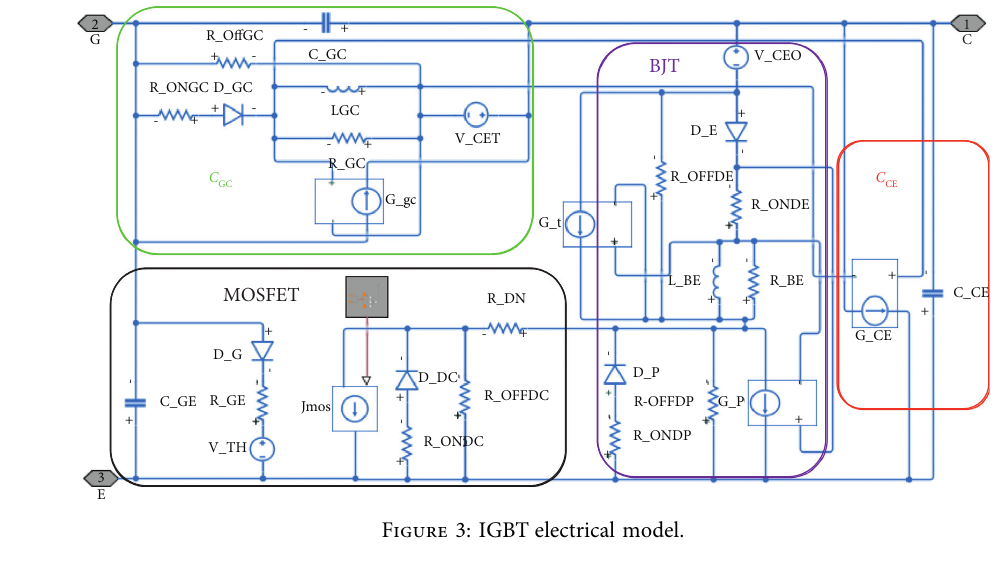
Figure 3: IGBT electrical model.